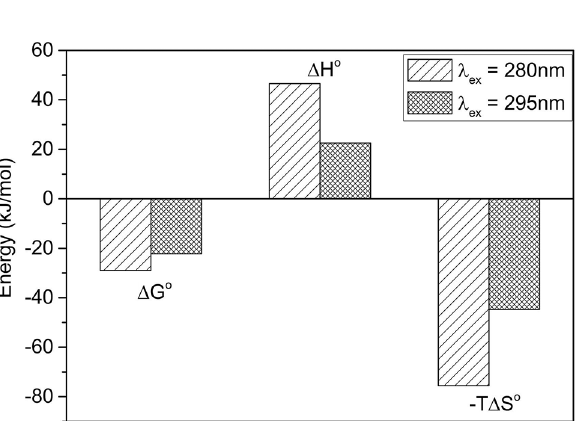
Figure 2. Energy contributions to the interaction between Ac 2-26 and PL at different excitation wavelengths (280 nm and 295 nm). Monitoring the microenvironment of the interaction around the aromatic tryptophan residue. ΔG = Gibbs free energy changes, ΔH = enthalpy changes, ΔS = entropy changes, T = temperature. Data were taken, with permission, from experiments performed by the authors Contessoto NSA and Cornélio ML, and figure printed in 96